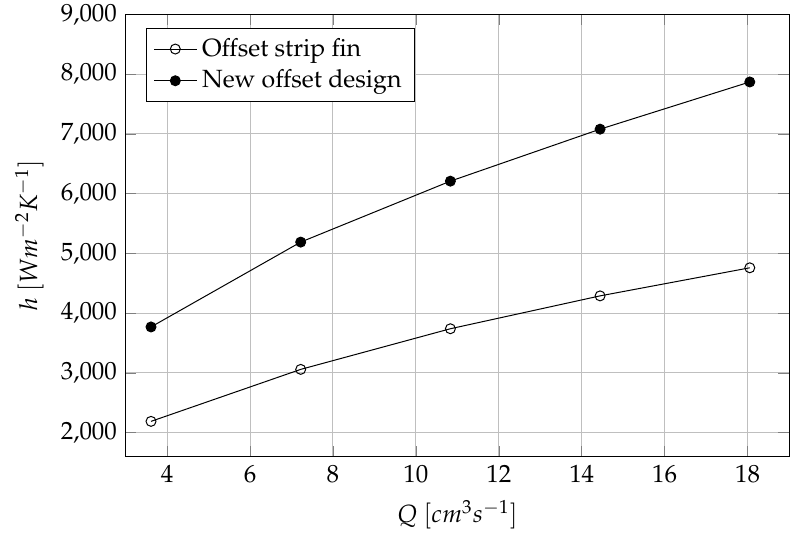
Figure 12. Heat transfer coefficient ( h ) in different volumetric flow rates for conventional offset strip fin design and new offset design.